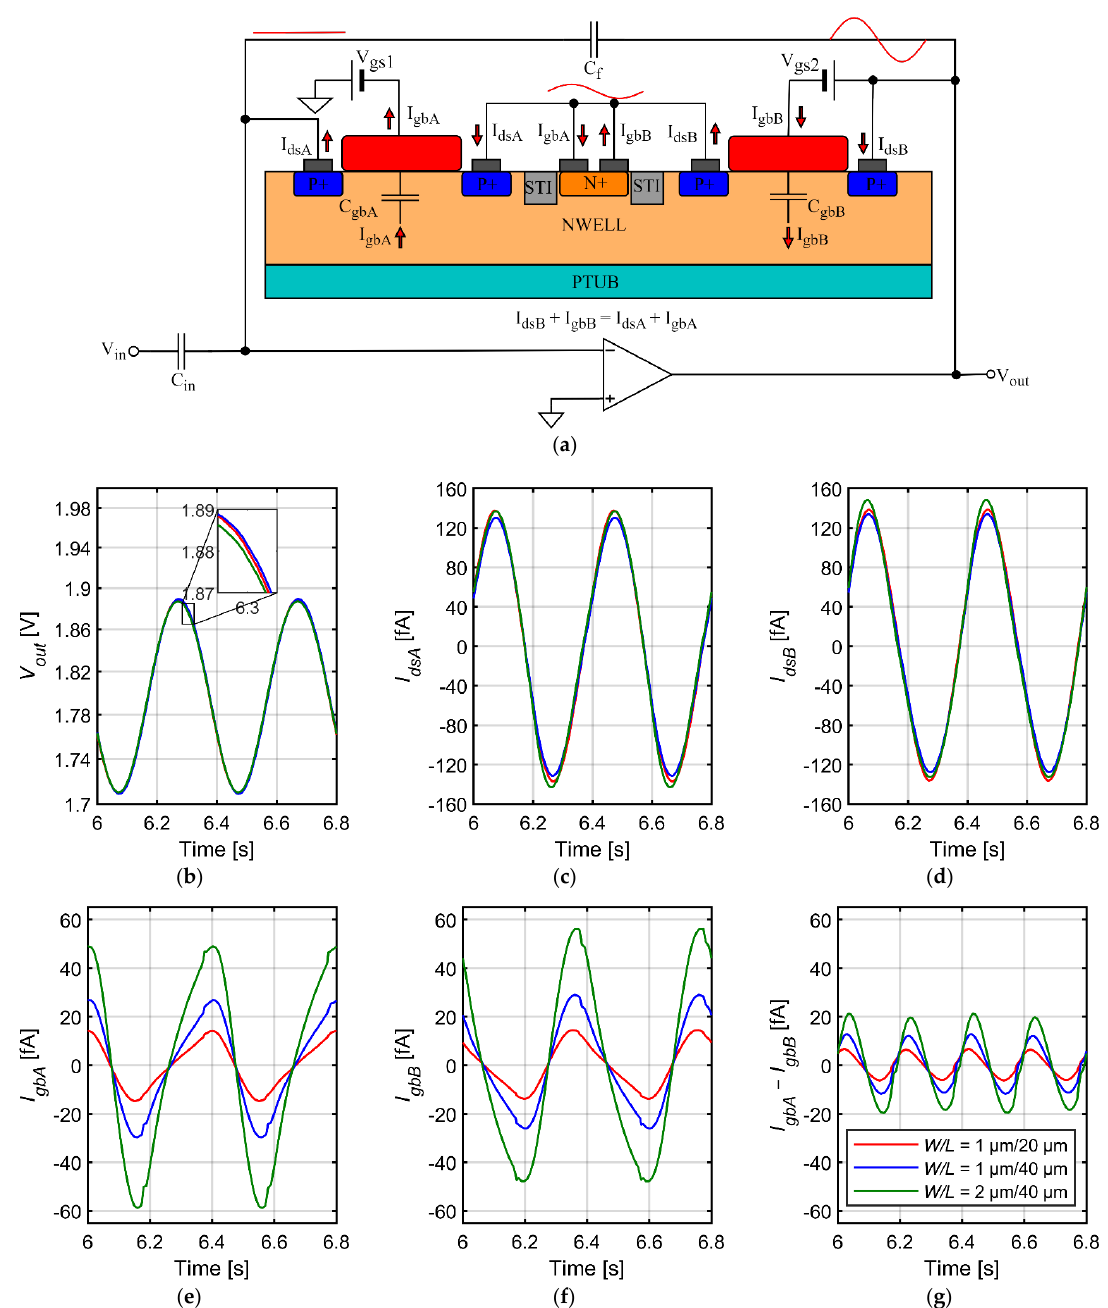
Figure 4. Results of transient simulations for a sinewave signal of 2.5 Hz for three different sizes of transistors composing the pseudoresistor: ( a ) Design of the preamplifier with a model of the fixed- V gs pseudoresistor; ( b ) Output voltage; ( c – f ) Drain-source currents and the gate-bulk currents for transistors A and B; ( g ) Difference between gate-bulk currents for transistors A and B.